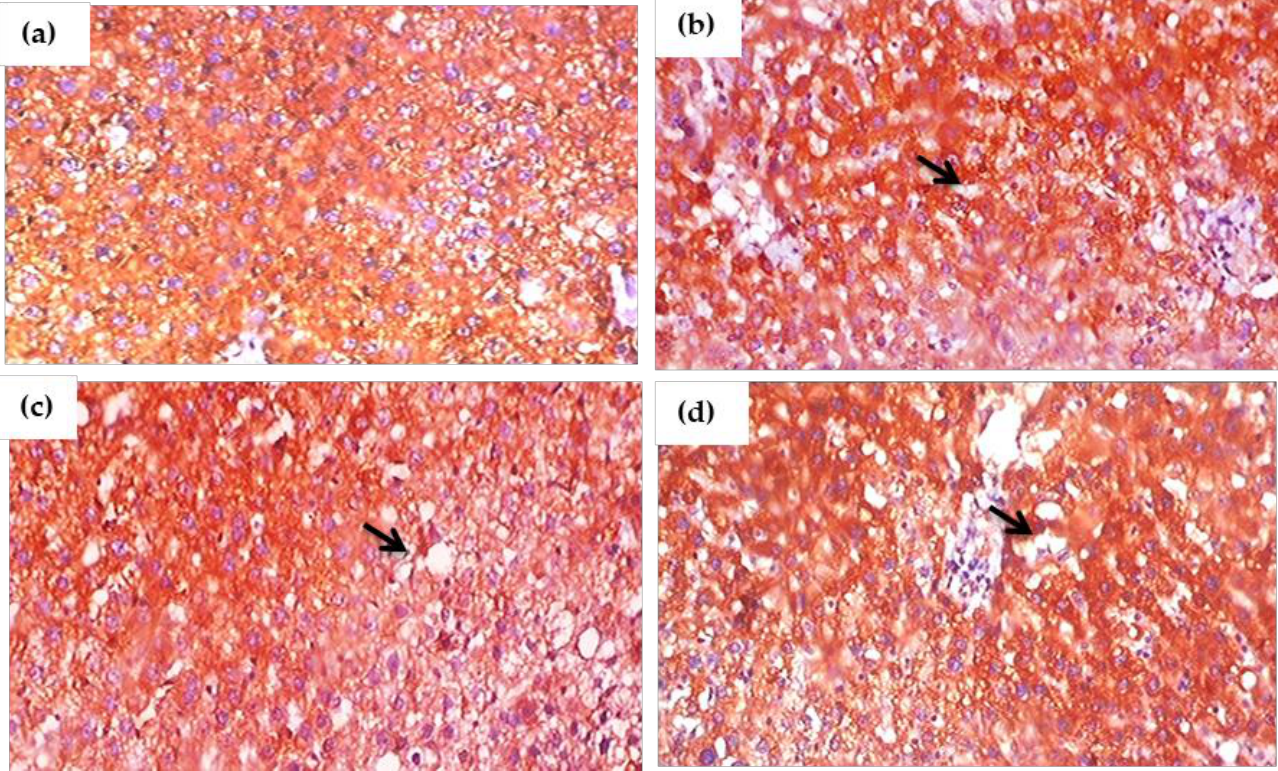
Figure 10. ( a – d ). Immunohistochemical evaluation of the effect of glyphosate on TNF- α protein expression in the liver sections of experimental rats. This image depicts exemplary IHC photomi- crographs (100 × magnification) of TNF- α staining intensity (black arrows) in the liver tissues. ( a ) Normal control rats showing small and large diameter hepatocytes; ( b ) glyphosate-exposed rats (50 mg/kg b.wt.) showed an mild expression of TNF- α with change in intensity that reflexed mild hy- dropic degeneration; ( c ) glyphosate-treated rats (100 mg/kg b.wt.) showed an elevated expression